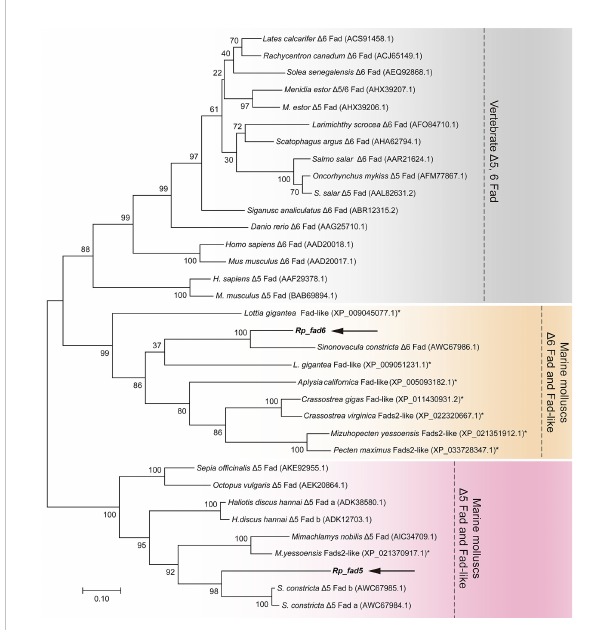
FIGURE 4 Phylogenetic tree comparing the deduced aa sequences of Rp_ fad5 and Rp_ fad6 with their orthologues from representative vertebrates and invertebrates. The tree was constructed using the maximum likelihood method by MEGA 7.0. The horizontal branch length is proportional to the aa substitution rate per site. The numbers represent the frequencies (%) with which the tree topology presented was replicated after 1,000 iterations. An asterisk marks Fad genes of invertebrates that have not been functionally characterized to date.